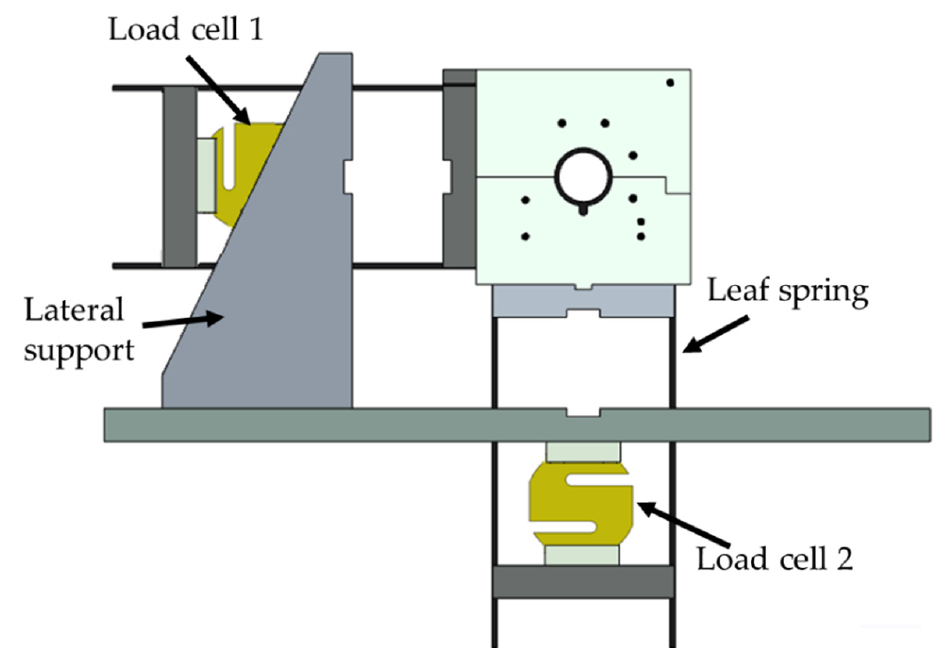
Figure 9. Bearing pedestal frame.